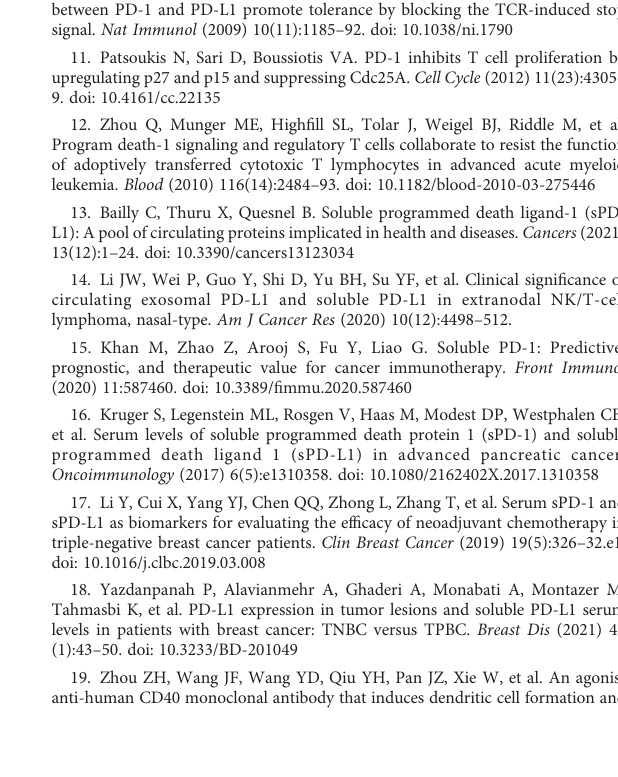
SUPPLEMENTARY FIGURE 1 The pattern of PD-L1 in breast cancer and its inhibition by speci fi c antibodies. The expression of PD-L1 and PD-1 in breast cancer cell lines was analyzed by fl ow cytometry. MDA-MB231 cells expressed high levels of PD-L1 (99.1%) compared with MCF-7 cells (11.3%) (A) . To con fi rm the relationship between PD-L1 and CD19 + B cells, a PD-L1-blocking antibody was used to block the expression of PD-L1 at different dilutions (B) . Data represent the mean and SEM of at least three independent experiments. SUPPLEMENTARY FIGURE 2 The absolute number of CD19 + CD24 + CD38 + B cells and IL-10 + B cells induced by sPD-L1. CD19 + B cells enriched from the peripheral blood of healthy individuals were treated with sPD-L1 at doses from 10 ng/mL, 100 ng/mL to 1000 ng/mL. After 2 days, CD19 + B cells were collected, and the absolute numbers of CD19 + CD38 + CD24 + B cells (n=6) and IL-10 + B cells on CD19 + CD38 + CD24 + B cells (n=6) were measured by fl ow cytometry (A).TheabsolutenumbersofCD19 + CD38 + CD24 + Bcells(n=6)andIL-10 + B cells on CD19 + CD38 + CD24 + B cells (n=6) were measured by fl ow cytometry induced by LPS or sPD-L1 individually or combinatorially (B). The absolute numbers of CD19 + CD38 + CD24 + B cells (n=6) and IL-10 + B cells on CD19 + CD38 + CD24 + B cells (n=6) were measured by fl ow cytometry induced by 5C11 or sPD-L1 individually or combinatorially (C). Data represent the mean ± SEM of at least three independent experiments and were analyzed by Student ’ s t test. ns, not statistically signi fi cant. * P < 0.05, ** P < 0.01, *** P < 0.001, and **** P <